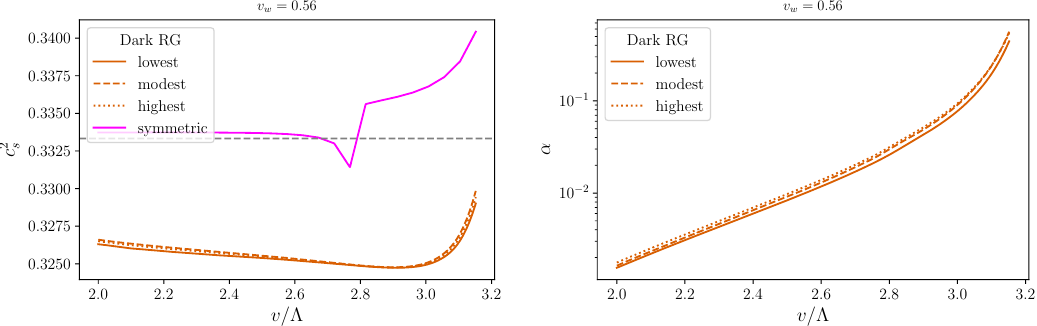
Figure 7 . Dark RG : the left panel shows the speed of sound calculated in the symmetric and broken phase using eq. (2.47) at the different levels of diligence. The gray dashed line corresponds to the bag model with c 2 = 1 / 3 . The symmetric phase (solid magenta) is only shown at highest diligence. s The right panel shows the strength of the phase transition at the different levels of diligence using eq. [(2.5), (2.12), (2.49)]. The temperatures are set to T